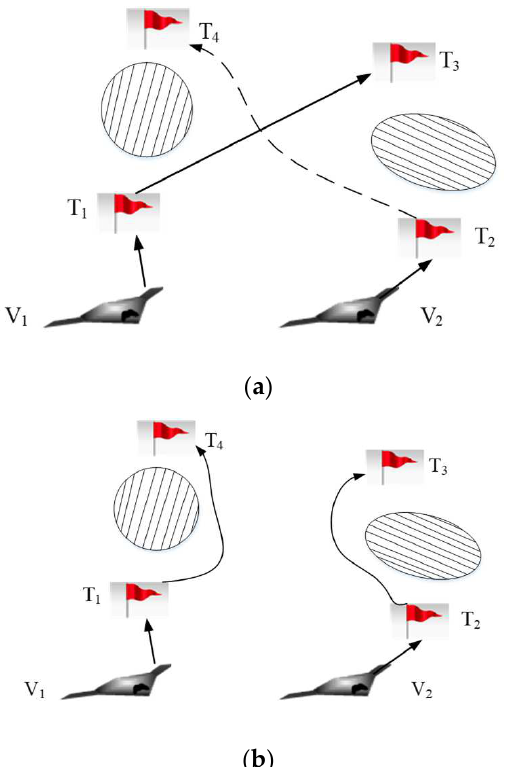
Figure 5. Sketch map for swap contract. ( a ) Initial task scheduling scheme; ( b ) Task re-scheduling